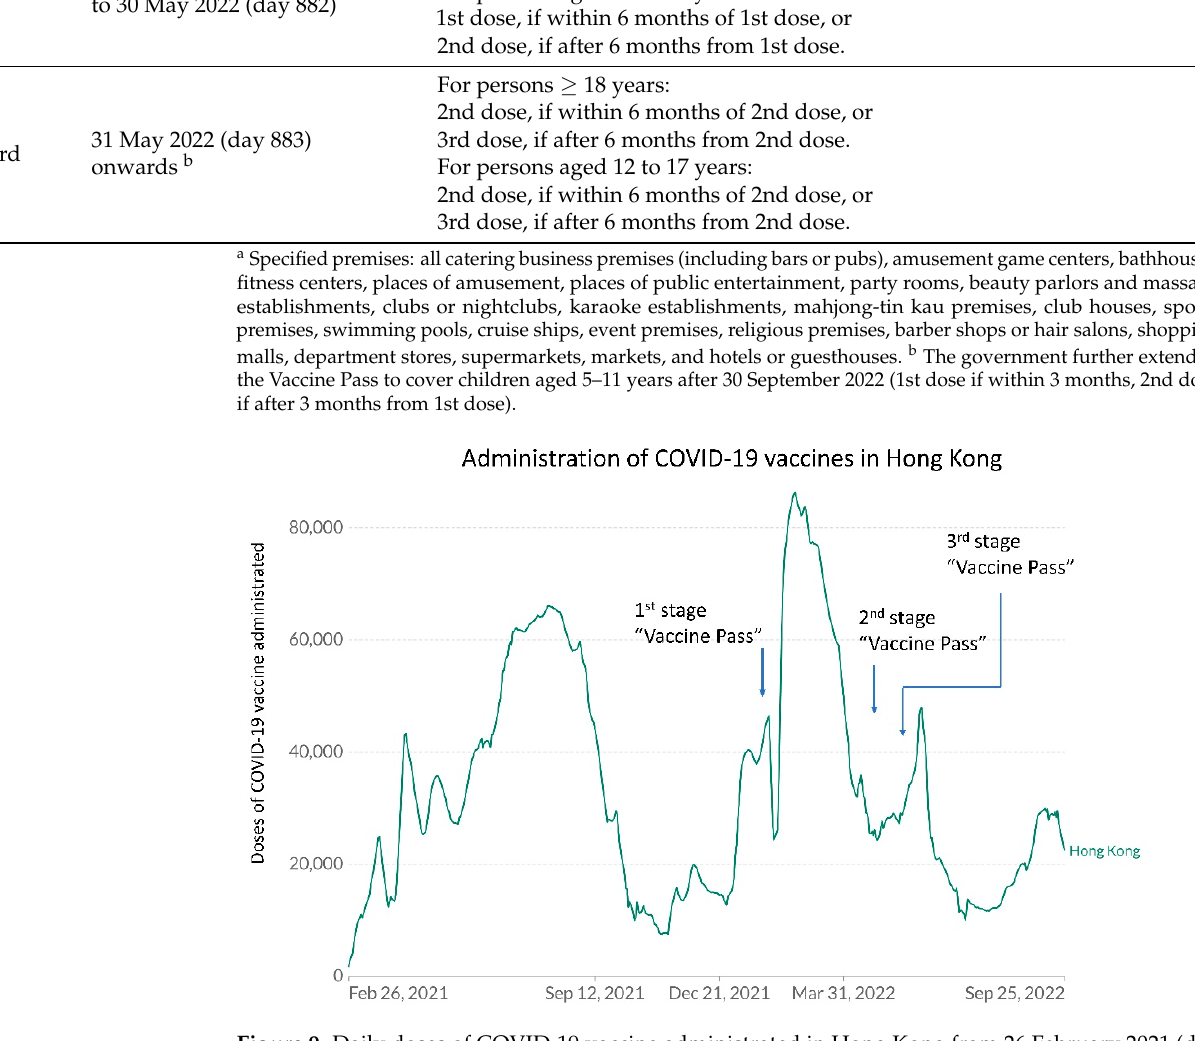
Figure 9. Daily doses of COVID-19 vaccine administrated in Hong Kong from 26 February 2021 (day 424) to 25 September 2022 (day 1000). The figure was generated from the website of “Our World in Data” [140] and formatted for presentation.